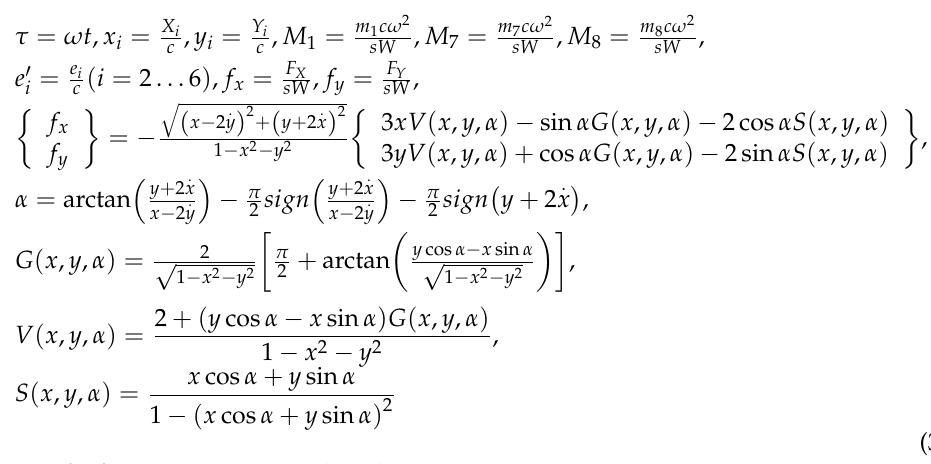
where f x , f y are nonlinear oil film forces in two perpendicular directions, respectively; ( R ) 2 ( L ) 2 is Sommerfeld coefficient [23]; ω is angular frequency; µ is coefficient s = µω RL c W 2 R of viscosity; R , L and W represent radius, length, and half weight of the rotor system, respectively. The system parameters shown in Table